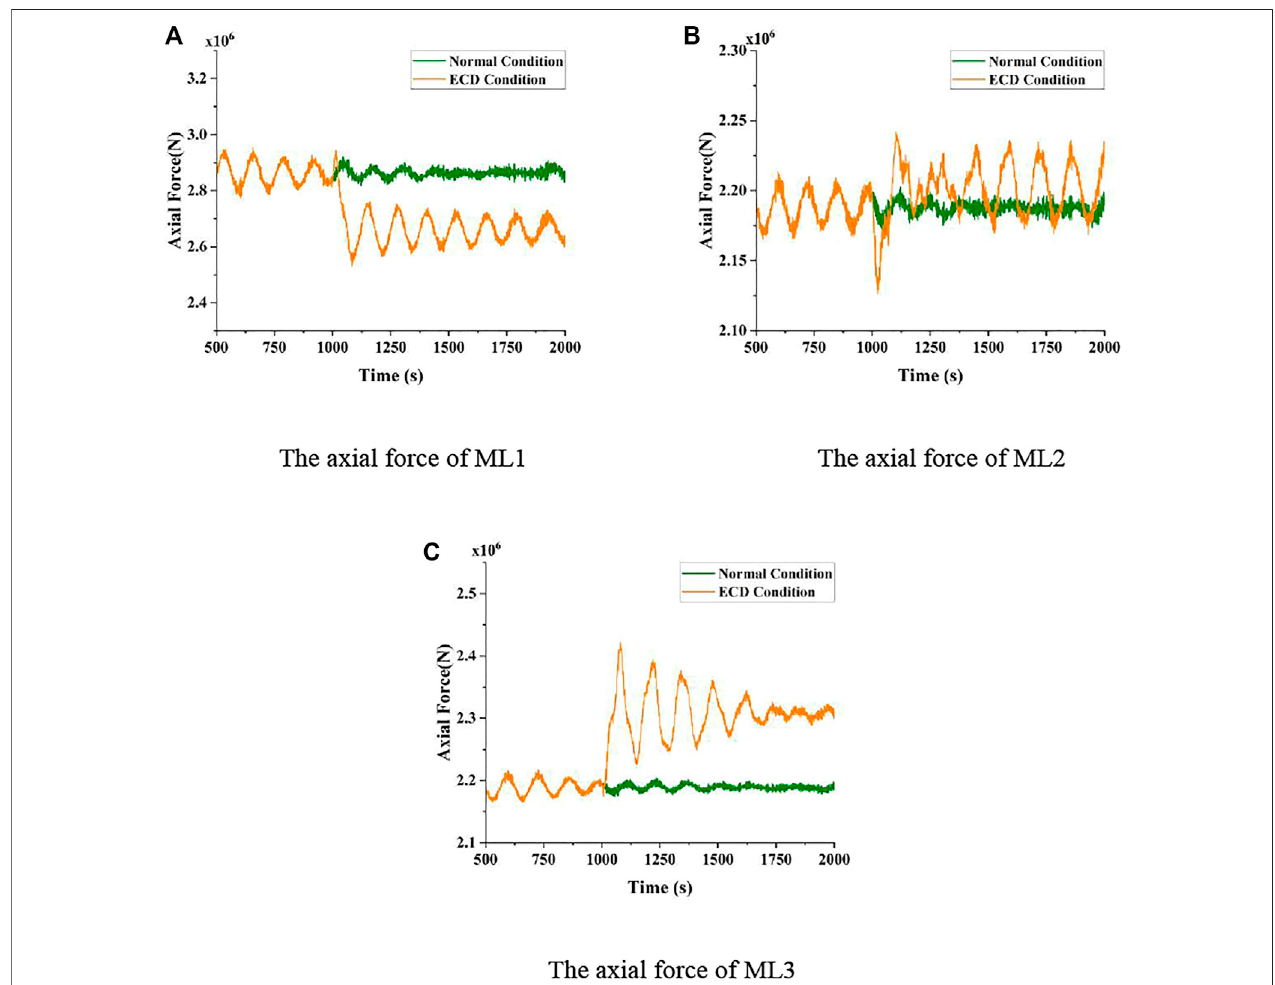
FIGURE 14 | Axial force response of mooring lines of the 15 MW FOWT under the normal condition and ECD condition. (A) Axial force of ML1. (B) Axial force of ML2. (C) Axial force of ML3.